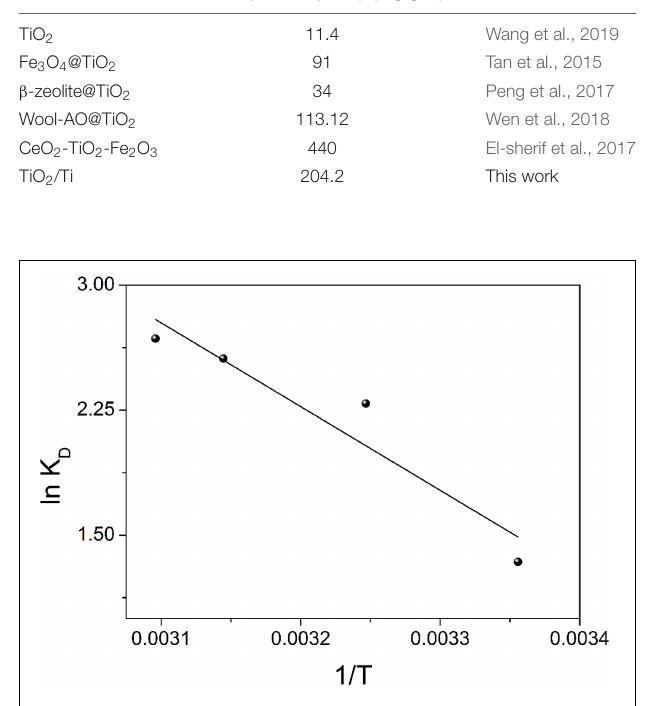
FIGURE 9 | Linear regression of ln K D and 1/ T .